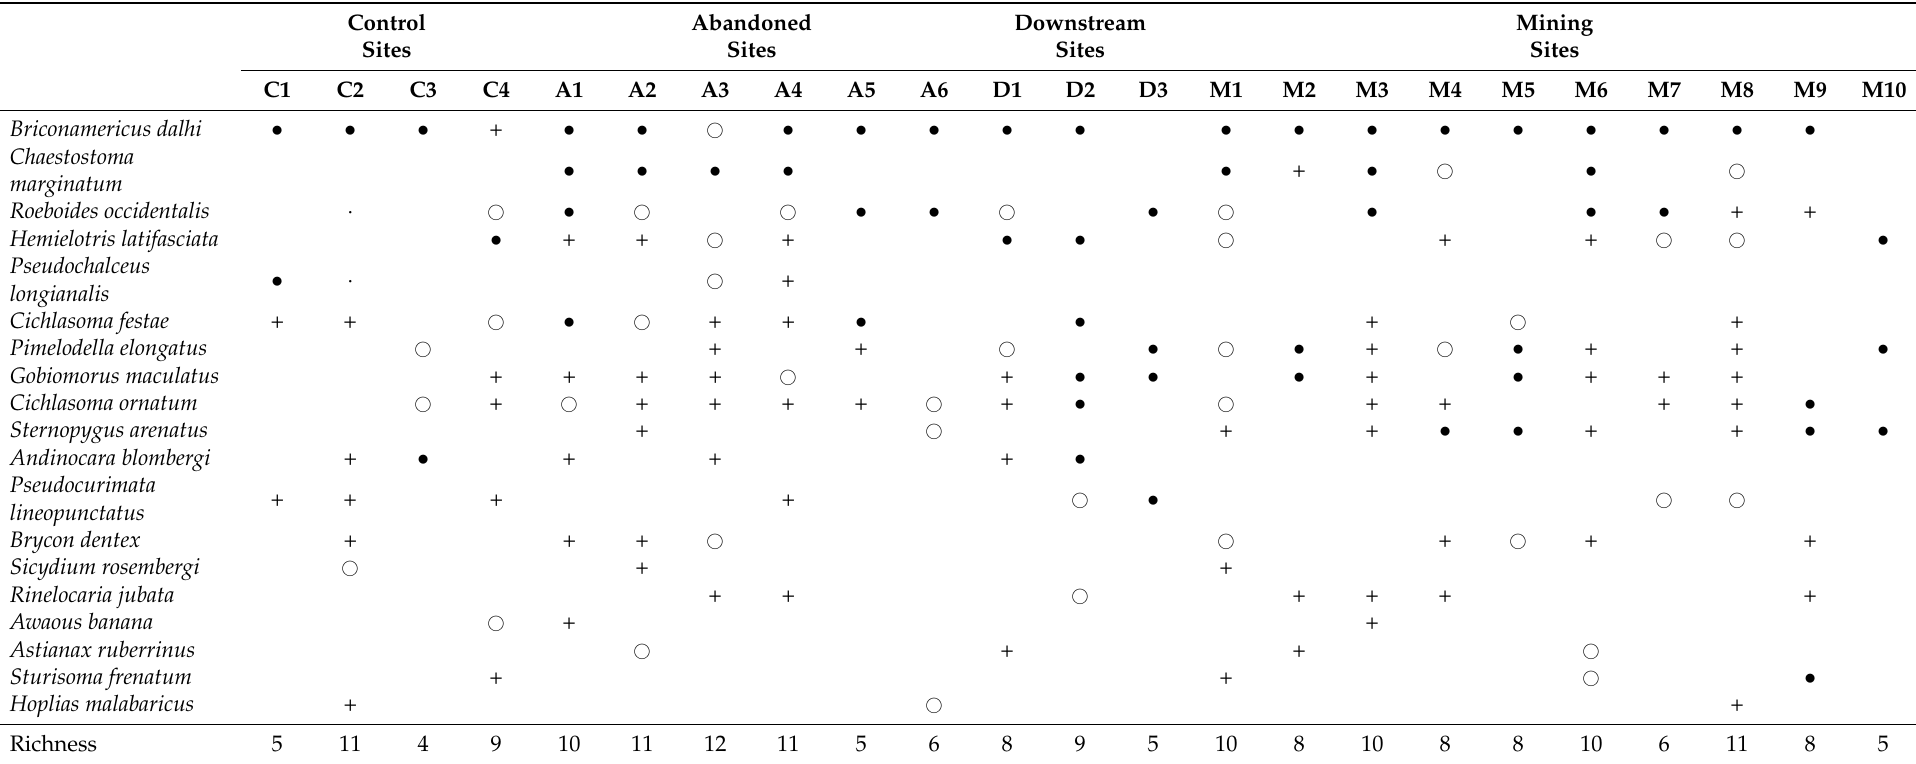
Table 3. Relative abundances of fish species collected at the study sites. Only species that appeared in three or more sites are represented • > 20%; • , 10–20%; , 5–10%; +, < (cid:35)